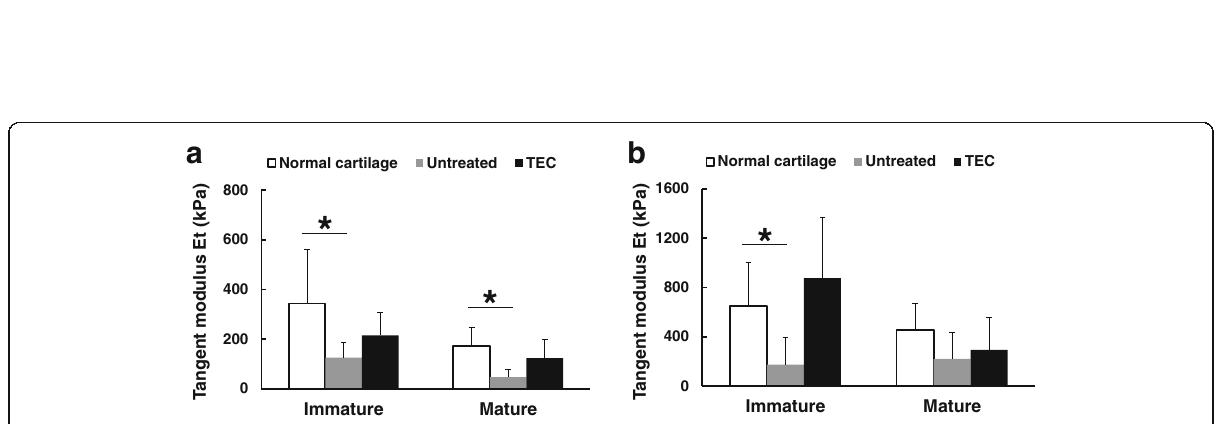
Fig. 5 The results of compression tests at a slow compression speed (4 um/s) ( a ) and at a fast compression speed (100 um/s) ( b ). Regardless of skeletal maturity, no significant differences were detected in the tangent modulus of the TEC-mediated repair tissue and that of normal cartilage at either compression speed. Conversely, untreated defects, whether in immature or mature recipients, showed significantly lower tangent modulus than did normal cartilage at either compression speed. * ; p <0.05. Quoted and modified from Shimomura et al. , Biomaterials